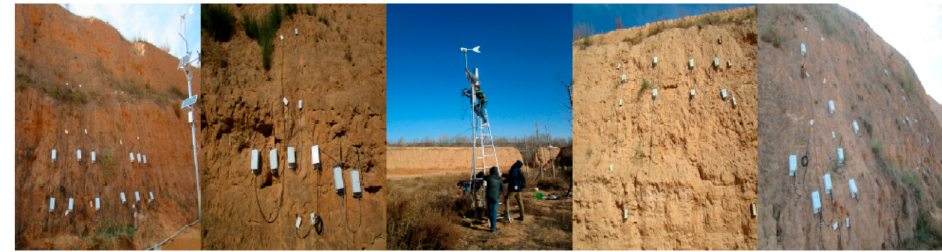
Figure 8. Photos of IoT nodes layouts in the 5 monitoring areas.